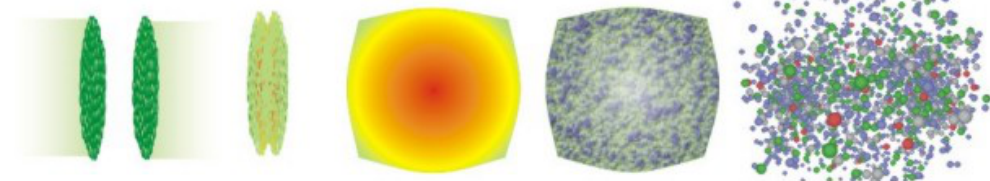
Figure 16. Cartoon of a collision of two ultra-relativistic nuclei. Left to Right : the two nuclei approach, collide, form a hot and dense equilibrated system, QGP expands and hadronizes, and finally hadrons rescatter and freeze out. The figure is taken from Ref. [311].